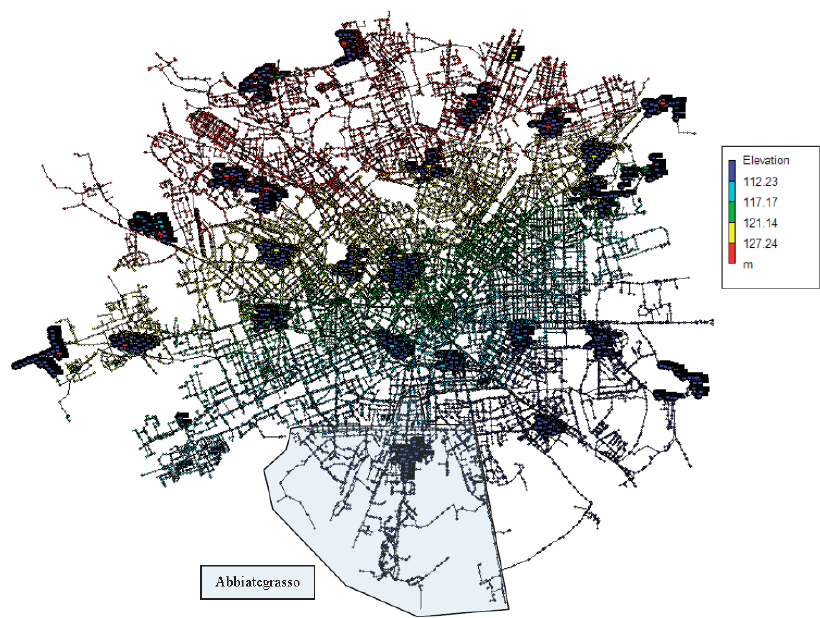
Figure 1. The urban water distribution network in Milan. Highlighted, in the South, the Pressure Management Zone (PMZ) named “Abbiategrasso”, where a pilot zone was identified for the installation of Automatic Meter Reading (AMRs).